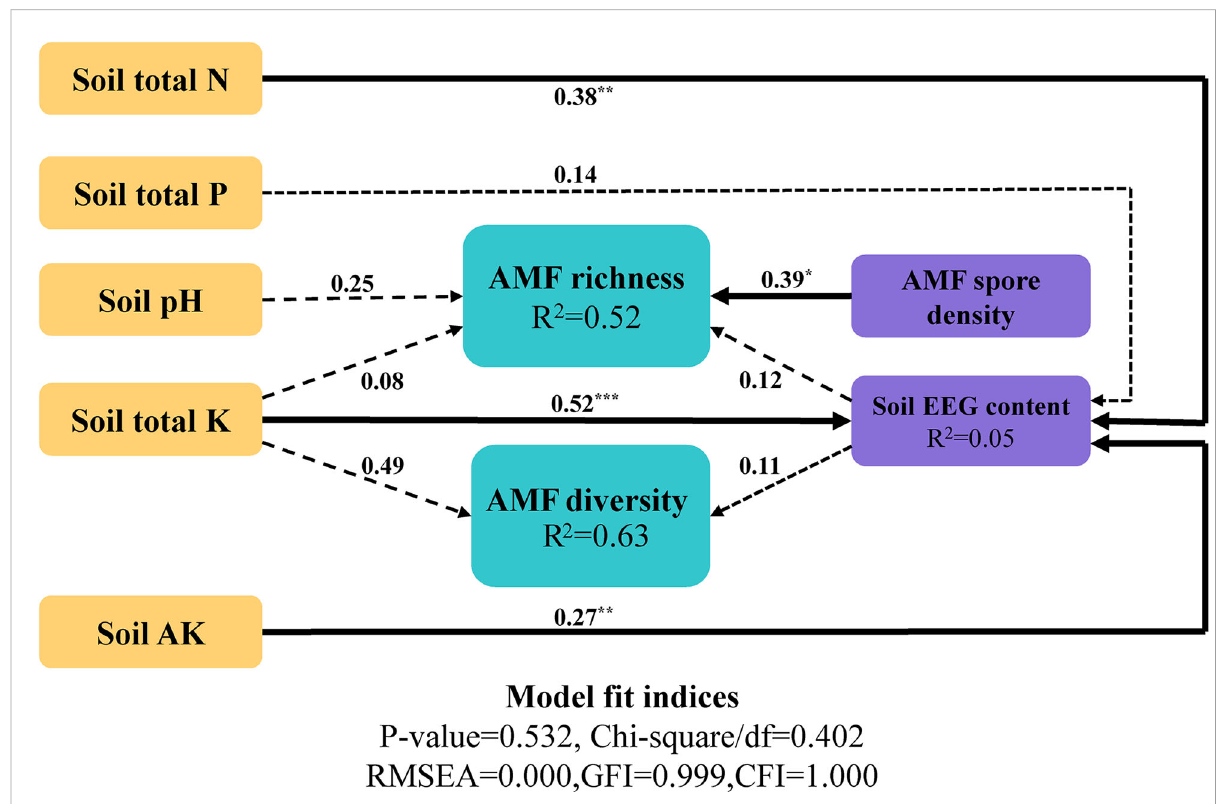
FIGURE 7 Structural equation model of the effects of environmental factors on the AMF community. Signi fi cant pathways are marked with asterisks *0.01 < p < 0.05; **0.001 < p < 0.01; *** p <